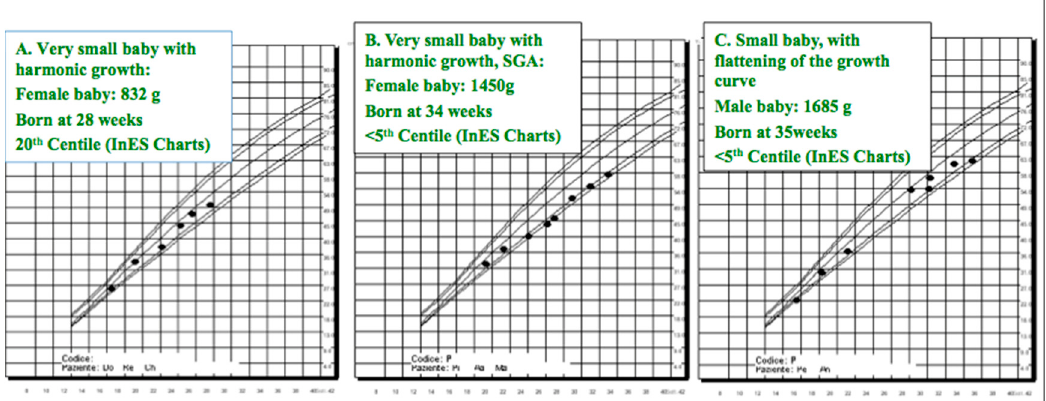
Figure 1. The different “small babies”: Growth curve of small, small for gestational age (SGA), intrauterine growth restricted (IUGR) babies (Y axis: weight and reference curves; X axis: gestational weeks). Legend: ( A ) is a very small, early preterm normal for gestational age child; ( B ) is a very small, early preterm, SGA but harmoniously grown, preterm child (mother and father also of small body size); child ( C ) is a small, SGA, preterm child with a flattening of the growth curve. Although ( B , C ) are identified also as IUGR, flattening of the growth curve may have a different (unfavorable) meaning as for life-long complications. (Courtesy of R. Attini and P. Gaiotti).